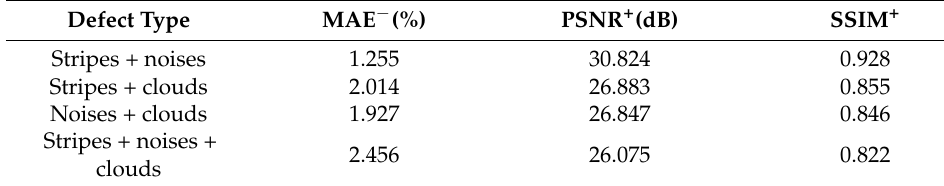
Table 12. Inpainting Quality on NWPU-RSISC45 Dataset with Combined Defects.